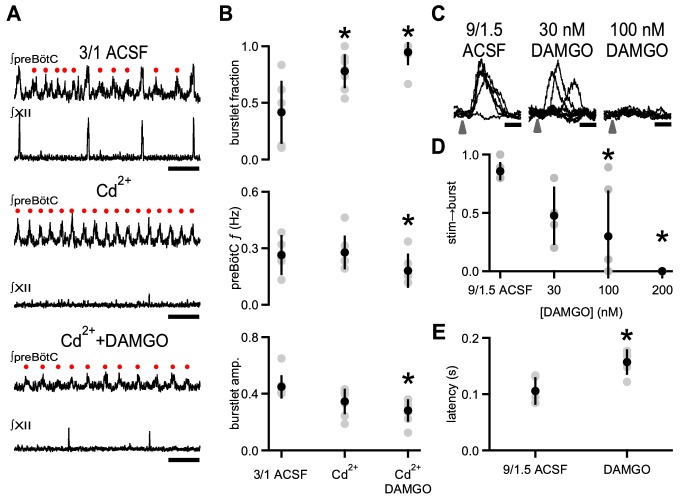
DAMGO specifically modulates preBötC rhythmogenesis.(A) Representative traces of ∫preBötC and ∫XII population activity in 3/1 ACSF control, 8 µM Cd2+, and 8 µM Cd2+ + 10 nM DAMGO. In 3/1 ACSF (top), rhythmic activity consisted of both burstlets (•) and bursts. After Cd2+ application (middle), preBötC bursts were no longer observed, and XII activity was abolished, leaving only a preBötC burstlet rhythm with a f similar to control. With addition of DAMGO (bottom), burstlet f and amplitude decreased. Note: the two large deflections in ∫XII (bottom) are not synchronized with preBötC activity, and are likely non-inspiratory or electrical artifact. Scale bar, 5 s. (B) Average burstlet fraction, preBötC f, and burstlet amplitude (amp.) in 3/1 ACSF control, 6–25 µM Cd2+, and 6–25 µM Cd2+ + 0.1–10 nM DAMGO. Addition of Cd2+ significantly increased the burstlet fraction while preBötC f and burstlet amplitudes were unchanged. Bath application of DAMGO significantly decreased preBötC f (consisting almost solely of burstlets) and burstlet amplitude. *, p<0.05, one-way ANOVA, post-hoc Tukey test, n = 8. (C) Overlays of representative traces of ∫preBötC from successive photoexcitation of 8 Dbx1+ neurons in control 9/1.5 ACSF, 30 nM DAMGO, and 100 nM DAMGO. The illumination pattern consisted of 10 µm soma-centered spots over the targeted neurons. Photoexcitation was provided by 405 nm holographic illumination of 500 µM MNI-glutamate. Arrow represents time of laser stimulation. In 9/1.5 ACSF, a failure was seen, but burst initiation was otherwise reliably successful. Bursts were consistently triggered after a ~ 100 ms latency. In 30 nM DAMGO, failures were more frequent when the same stimulation parameters were used, and the latency between laser stimulation and burst initiation was longer and more variable. In 100 nM DAMGO, bursts in this experiment were no longer triggered with the same stimulation parameters. Scale bar, 200 ms. (D) Average success rate (stim→burst) for burst initiation in control 9/1.5 ACSF conditions and in increasing concentrations of DAMGO using entraining stimuli that elicits >80% success in 9/1.5 ACSF. To entrain the rhythm, 5–10 Dbx1+ neurons were stimulated 8–20 times every 3–6 s. DAMGO produced a dose-dependent decrease in the success rate for triggering bursts with a significant reduction in success between control and at 100 nM and 200 nM DAMGO. *, p<0.05, one-way ANOVA, post-hoc Tukey test, n = 6. (E) Average latency between laser stimulation and burst initiation when bursts were successfully triggered during entraining stimuli was increased in 30 nM DAMGO compared to control 9/1.5 ACSF. *, p<0.05, Student’s t-test, n = 5.